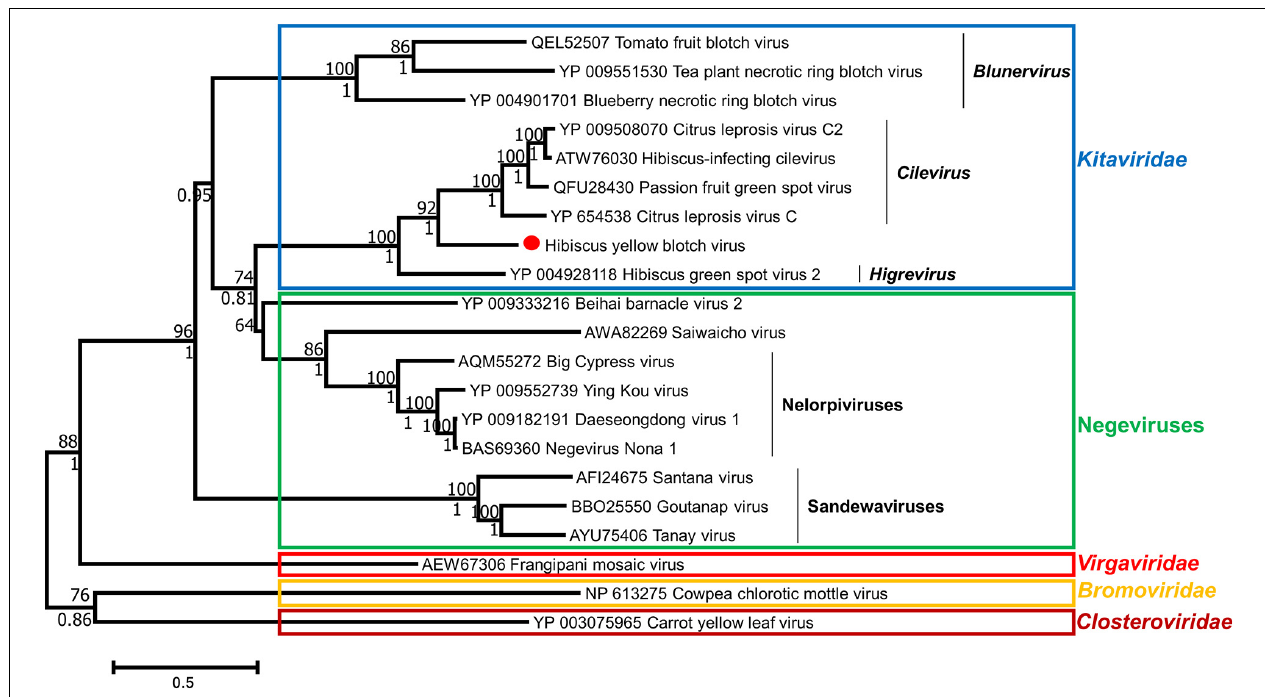
FIGURE 4 | Phylogenetic relationships among members of the families Kitaviridae , Virgaviridae , Bromoviridae , Closteroviridae and negeviruses based on an RNA-dependent RNA polymerase (RdRp) multiple protein alignment using CLUSTAL and inferred using maximum likelihood algorithm implemented in MEGA 7.0.25. Bootstrap values generated by maximum likelihood are shown above the branches after 1000 repetitions. Posterior probabilities that were calculated using Bayesian inference with three Markov Chain Monte Carlo runs of 10,000,000 generations and implemented in BEAST 2 are shown under the branches. Missing values indicate values below 50 (bootstrap) or 0.7 (posterior probability). GenBank accession numbers are provided prior to each virus name. Scale at bottom indicates the number of substitutions per given branch